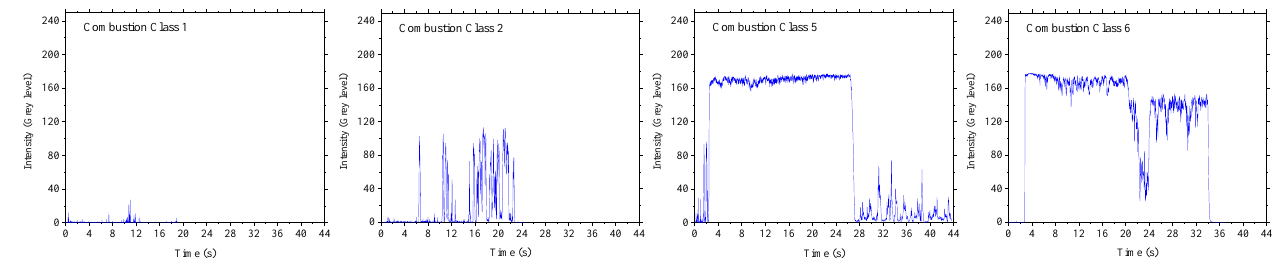
the flame is registered. For Combustion Class 6, the plasma turn-off at 20 s is associated with a transition zone to reach a stable flame without plasma support while attached to the burner mouth. Although the brightness level of the flame is reduced as the plasma support is removed, the flame propagates with slight fluctuation until the stop of the fuel feeding at 34 s.